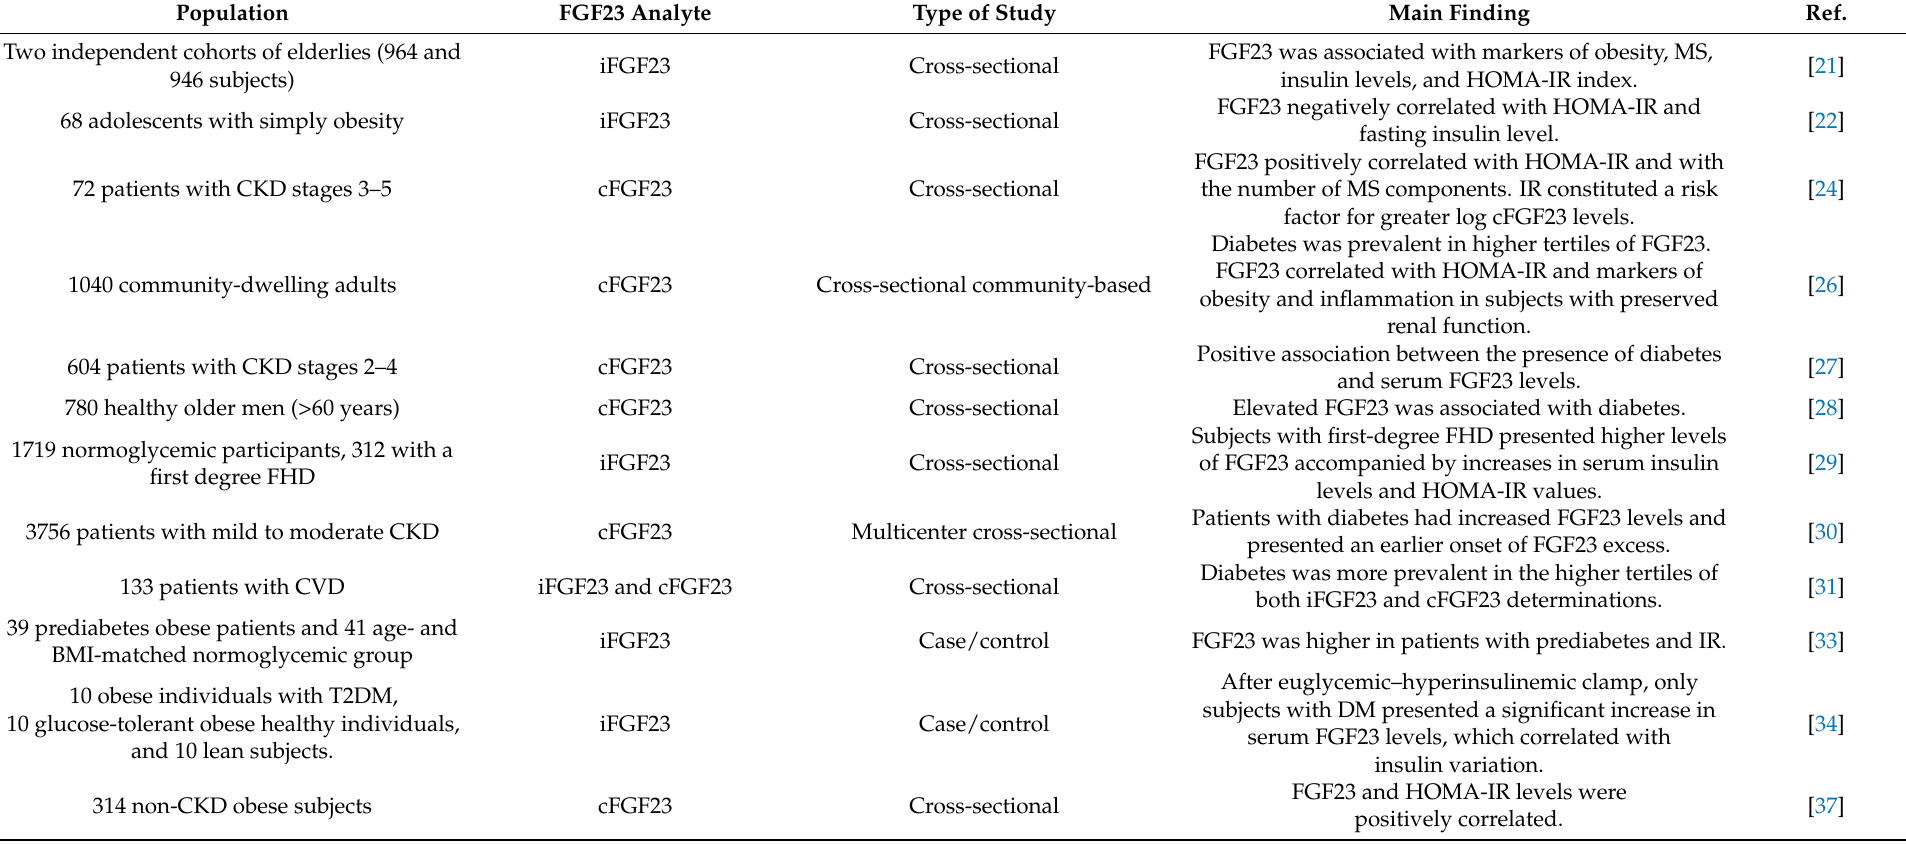
Table 1. Main clinical studies showing associations of FGF23 level markers of IR and